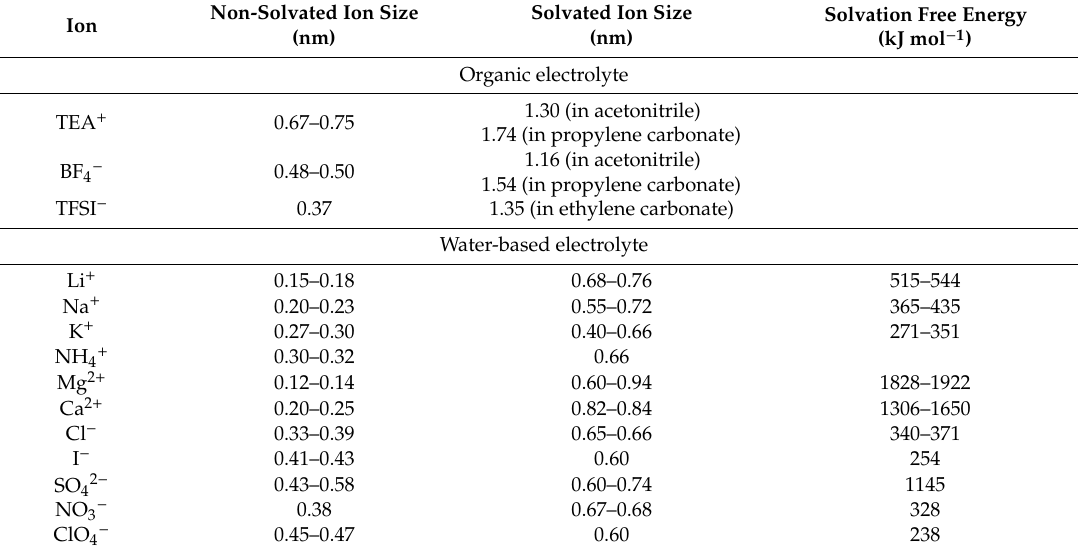
Table 9. E ff ective size of selected ions and their solvation free energy (based on various